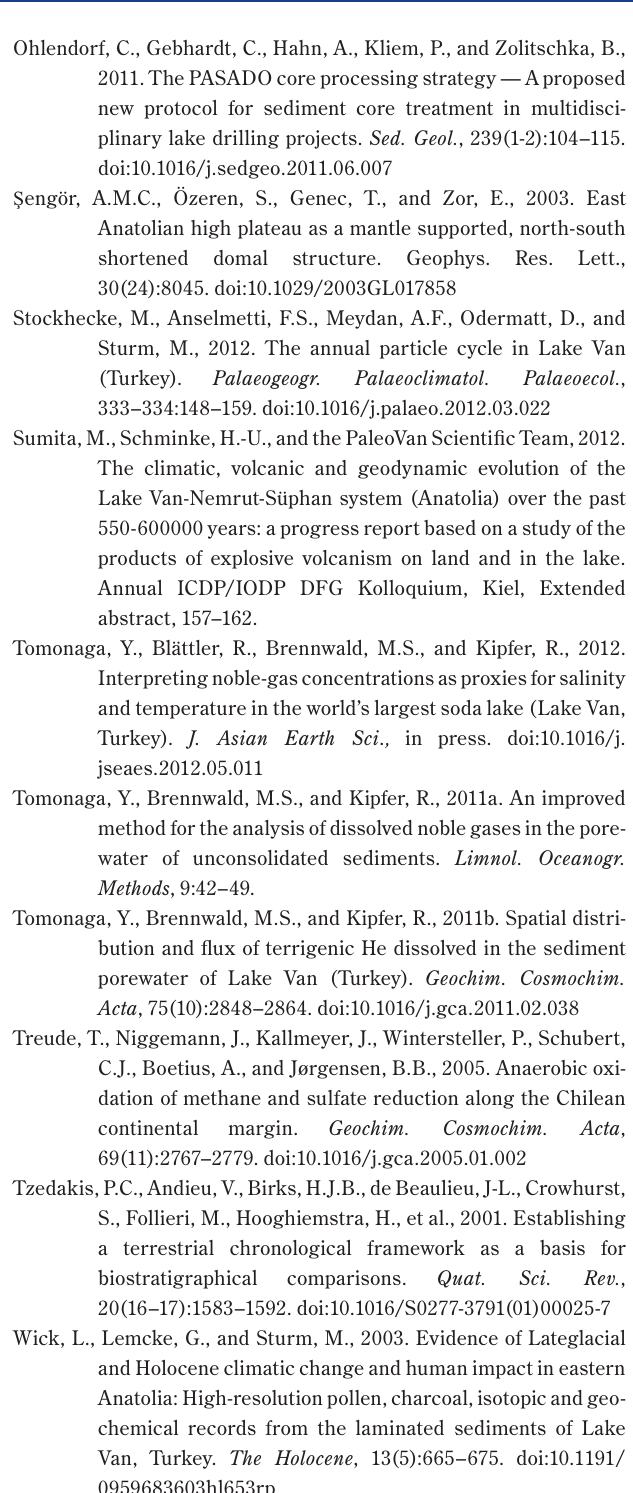
Fig. 7: Flavio Anselmetti, University of Bern Fig. 10: Jens Kallmeyer, GFZ Potsdam Fig. 11: PALEOVAN science team Fig. 12: PALEOVAN science team Fig. 13: PALEOVAN science team Fig. 14: PALEOVAN science team Fig. 15: ALEOVAN science team Related Web